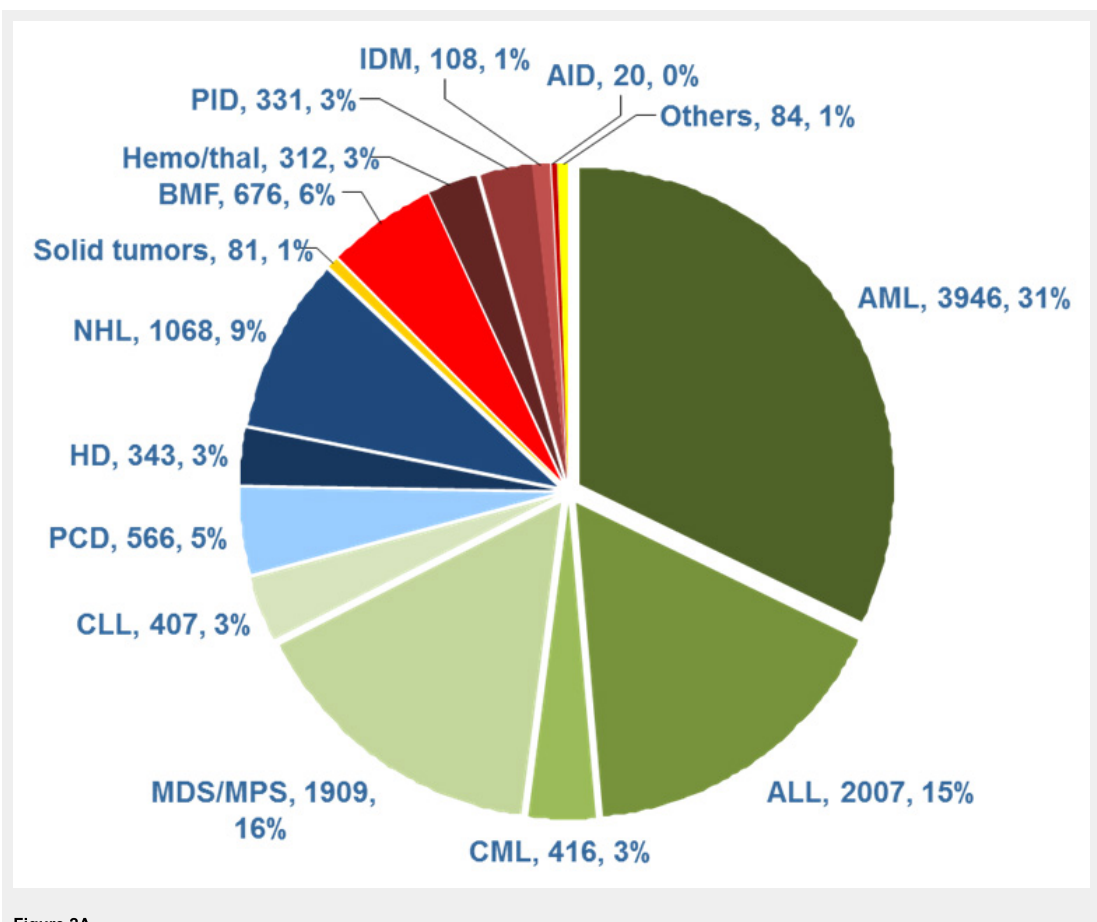
Figure 2A Indications for allogeneic HSCT in Europe in 2010 (reprinted from: Passweg JR, Baldomero H, Gratwohl A, Bregni M, Cesaro S, Dreger P, et al.; for the European Group for Blood and Marrow Transplantation (EBMT). The EBMT activity survey: 1990–2010. Bone Marrow Transplant. 2012;47(7):906-23 [3]). Abbr: AML Acute Myeloid Leukaemia, ALL Acute Lymphoblastic Leukaemia, CML Chronic Myeloid Leukaemia; MDS/MPS Myelodysplastic Syndromes/Myeloproliferative Neoplasias, CLL Chronic Lymphocytic Leukaemia, PCD plasma cell disorders, HD Hodgkin Lymphoma, NHL Non Hodgkin Lymphoma, Hemo/thal Hemoglobinopathies/Thalassemias, BMF Bone Marrow Failure, PID Primary Immunodeficiencies, IDM Inborn Errors of Metabolism, AID Autoimmune